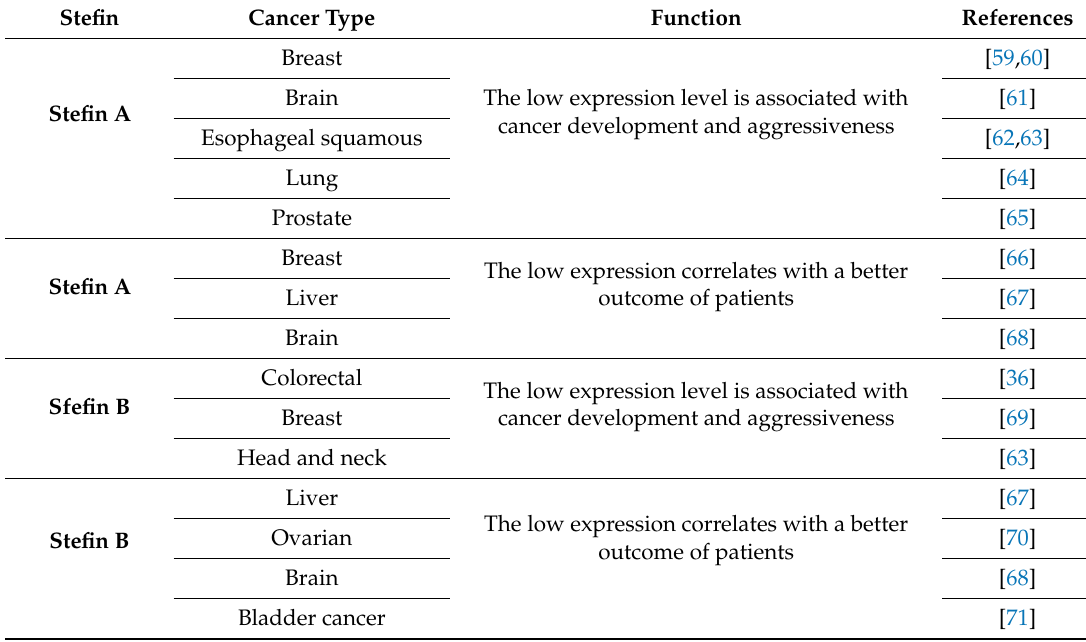
Table 2. Role of stefins in human